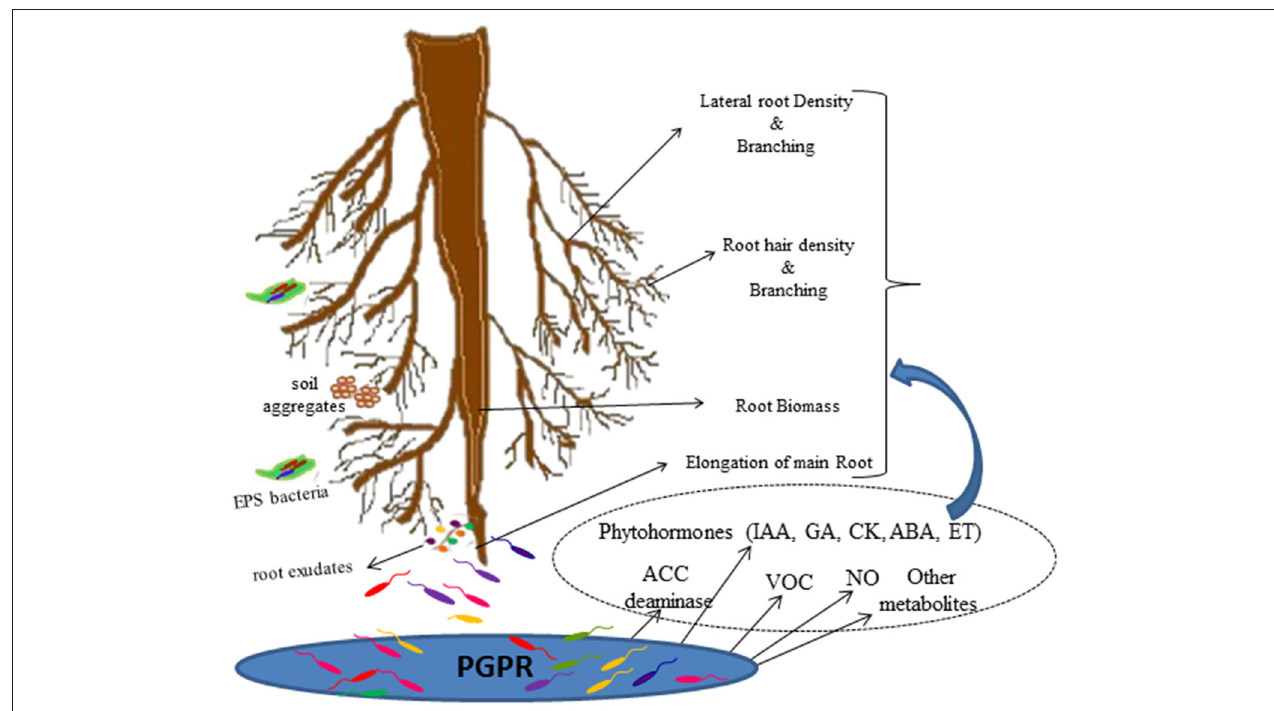
FIGURE 2 | PGPR-Root